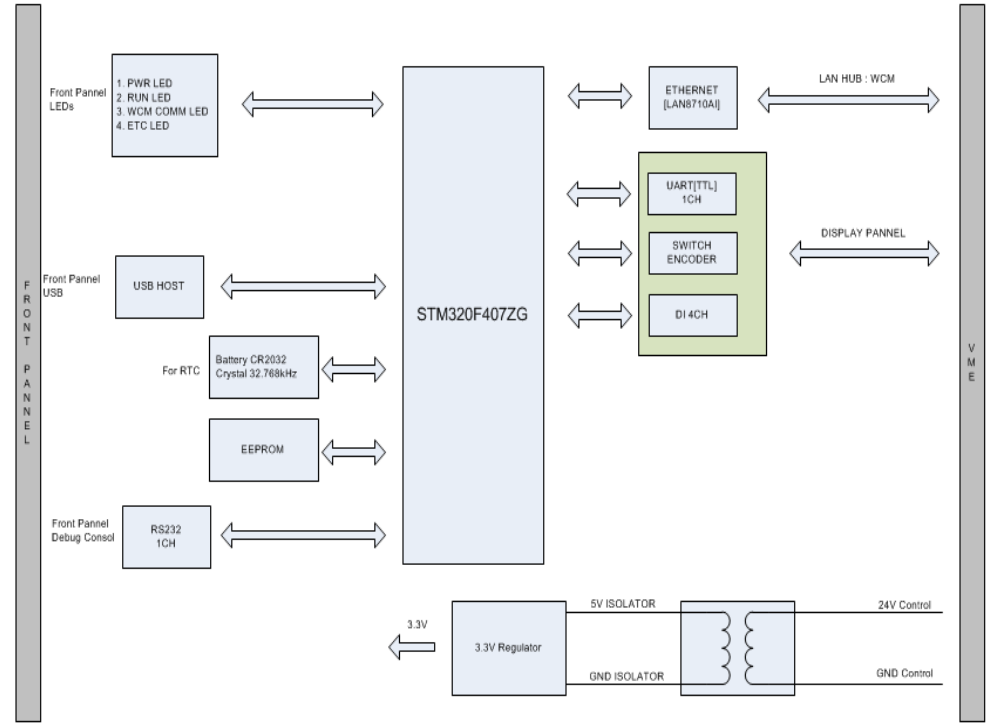
Figure 7. Block diagram of the central control module (CCM).